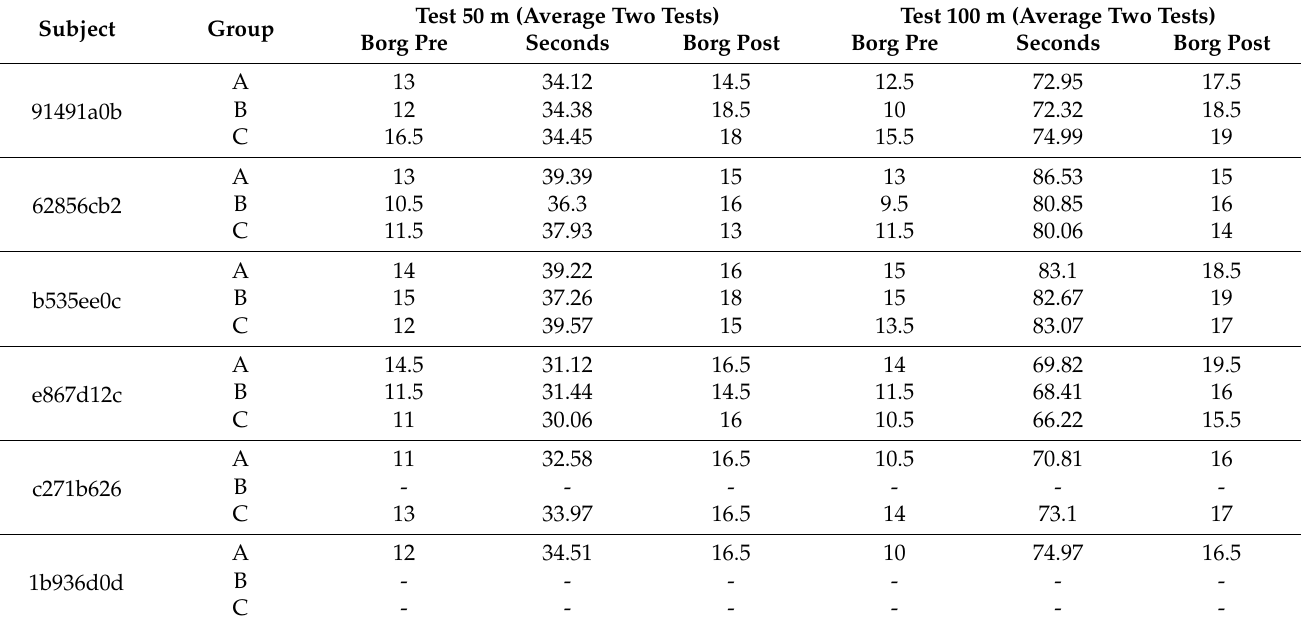
Table 2. Results per individual of their performance both in time and perceived effort in the 50 m and 100 m swimming events.